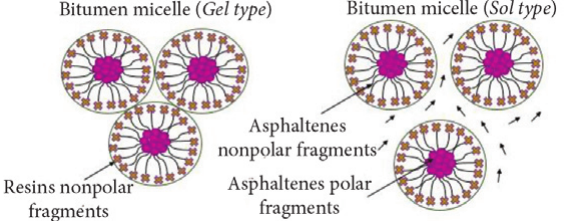
fig. 11. Distribution of micelles in the structures of type Sol and Gel and comparison with a micelle existing in nature